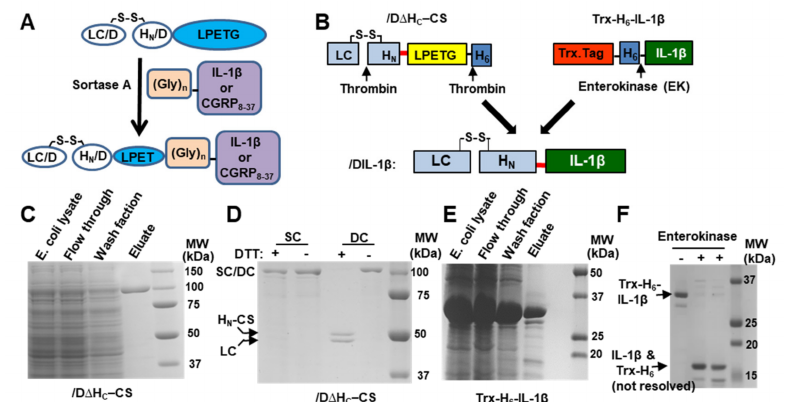
Figure 1. Protein engineering BoNT / D core-therapeutic and targeting ligand. ( A ) Schematic of the sortase A-mediated conjugation strategy. Sortase A can ligate recombinant (Gly) 5 -IL-1 β or attach (Gly) 3 -CGRP 8-37 to the C-terminal of LC.H N / D via recognition of the LPETG motif and cleavage of the bond between T and G. ( B ) Illustration of protein engineering / DIL-1 β via ligation of Gly 5 -IL-1 β to / D ∆ H / D ∆ H / D core-therapeutic with a C-terminal sortase C -CS by sortase A. C –CS depicts BoNT